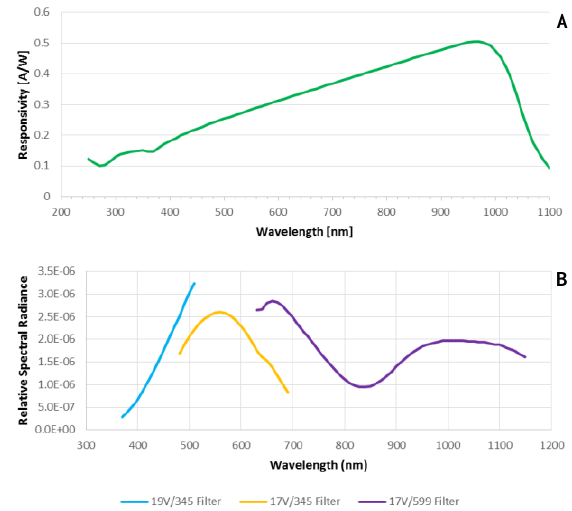
Figure 3: The responsivity of the silicon photodiode (A); The relative spectral radiance of the monochromator at given voltages using specific filters